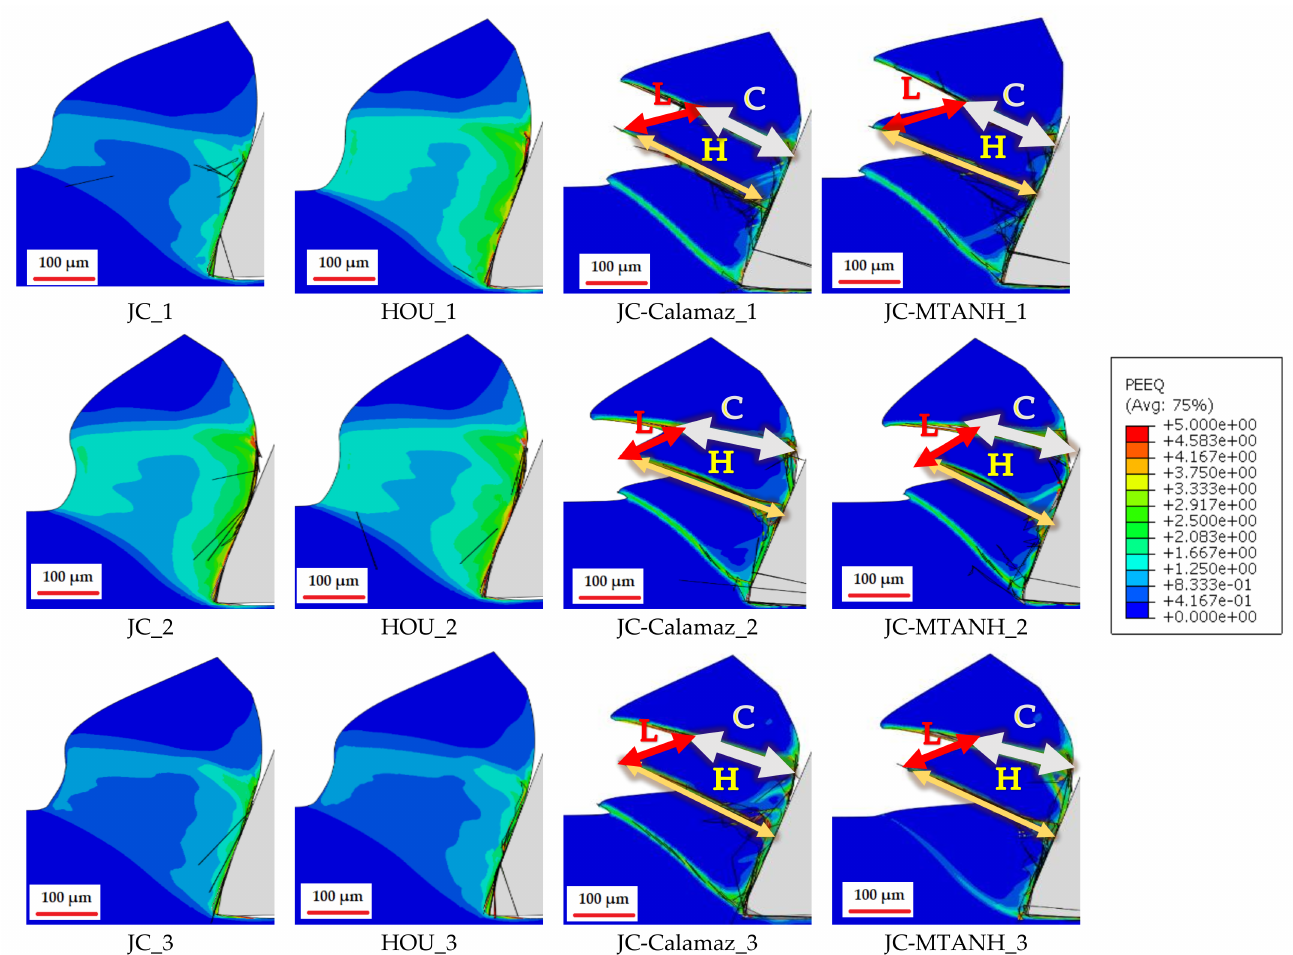
Figure 10. Equivalent plastic strain contour for uncut chip thickness of 280 µ